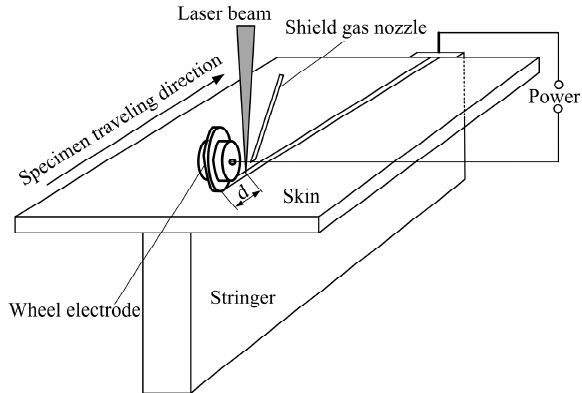
Figure 1. Schematic diagram of the set-up of electric current-aided laser stake welding of a T-joint. During the electric current-aided laser stake-welding process, the laser beam was focused on the top of the skin surface using a 190 mm focal length lens, and the focused spot diameter was 0.2 mm. The wheel electrode touched the top of the skin surface. While the T-joint specimens moved with the traveling device, the wheel electrode rotated about a fixed axis. The distance, d (illustrated in Figure 1), between the position of the bottom of the wheel electrode and the position of the laser beam focus was fixed at 25 mm. The flow rate of the argon shielding gas was 25 L/min.